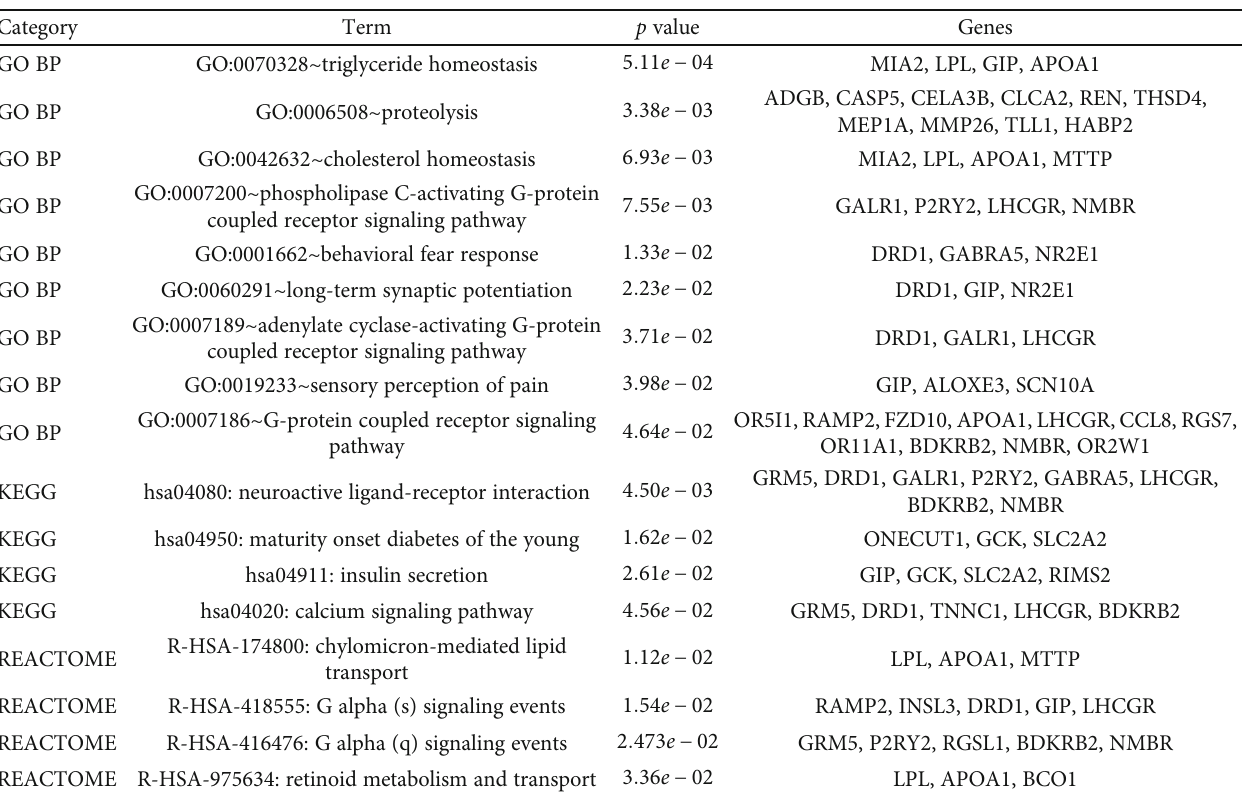
Table 5: Function enrichment